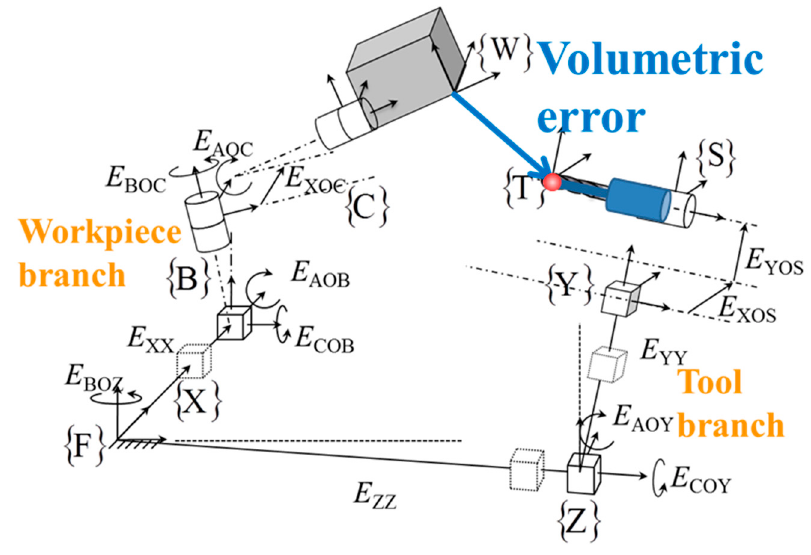
Figure 2. Estimated error parameters in the machine kinematic chain (modified from reference [16]).